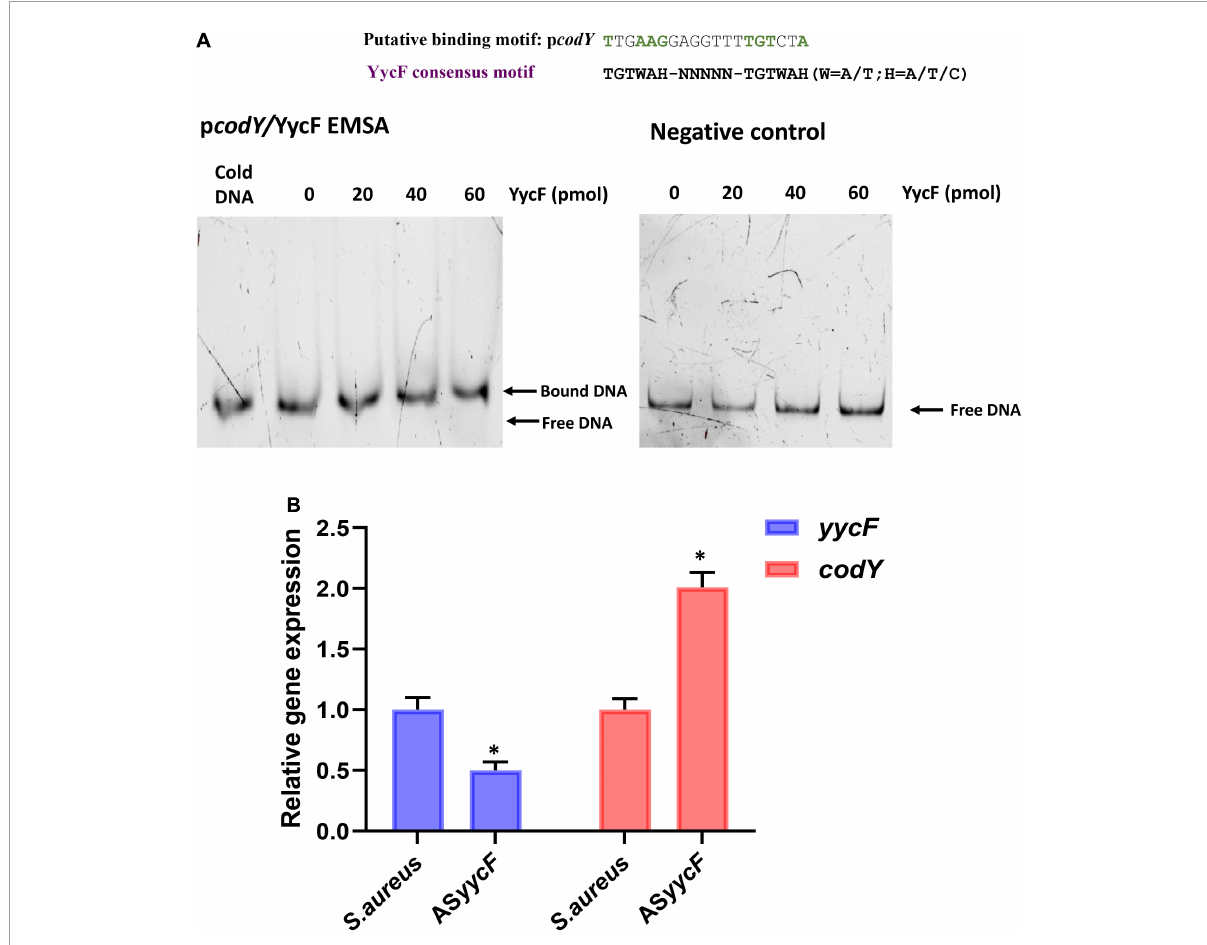
FIGURE1 YycF negatively regulates codY expression. (A) Consensus YycF binding motif and candidate sequences in promoters of codY . TGTWAH-NNNNN-TGTWAH, where W is A/T and H is A/T/C; EMSA in which promoter regions were obtained by PCR and FAM-labeled. As the negative control, a DNA fragment the same size as the promoter region and similar AT: GC mole ratio, but missing the YycF consensus binding sequence, was used to rule out non-specific binding. (B) Quantitative RT-PCR analysis showed the gene transcripts in S. aureus , and AS yycF strains. S. aureus gene expression was relatively quantified by RT-PCR using 16S as an internal control ( n = 5, ∗ P <